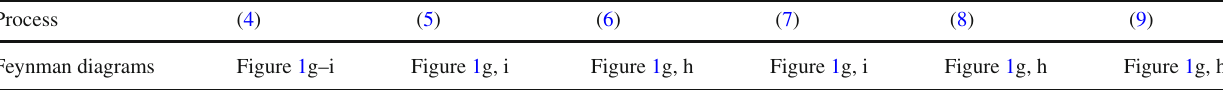
Figure 1g, h Figure 1g,